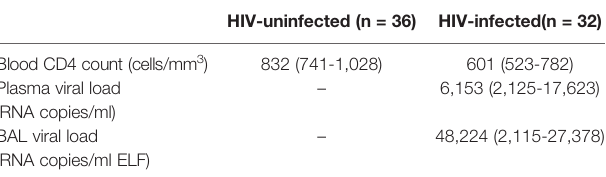
TABLE 1 | Clinical characteristics of study